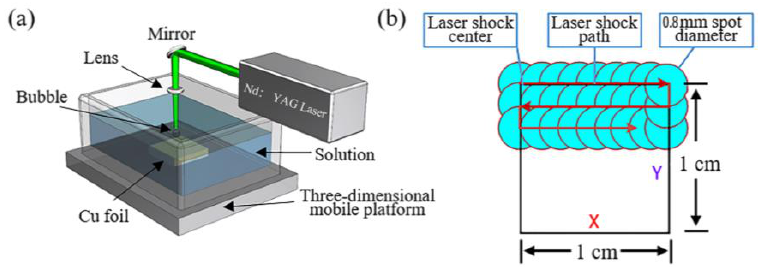
Figure 26. ( a ) Experimental setup of laser deposition by PLAL. ( b ) Laser scan path [32].